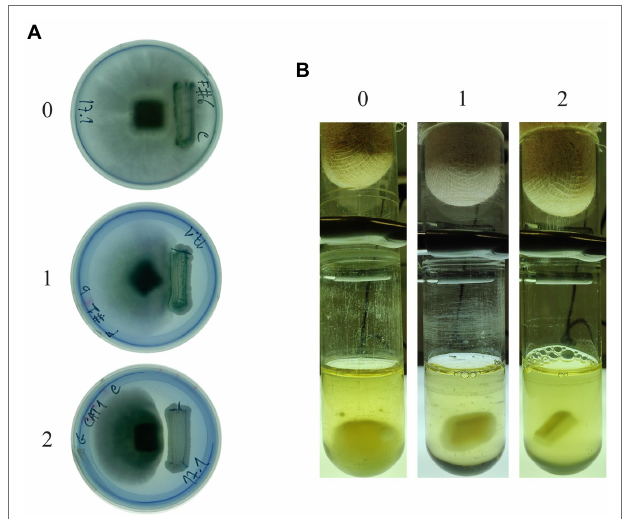
FIGURE 1 | Empirical classification scales of antagonistic response in solid (A) and liquid (B) ME at 30 ° C. Level 0 corresponds to a high filamentous fungal resistance (the absence of inhibition); level 1 corresponds to a weak inhibitory effect; and level 2 corresponds to a clear antagonistic growth inhibition effect. In (B) , the culture media was replaced with fresh ME to allow visualization of the results without the turbidity resulting from yeast growth.